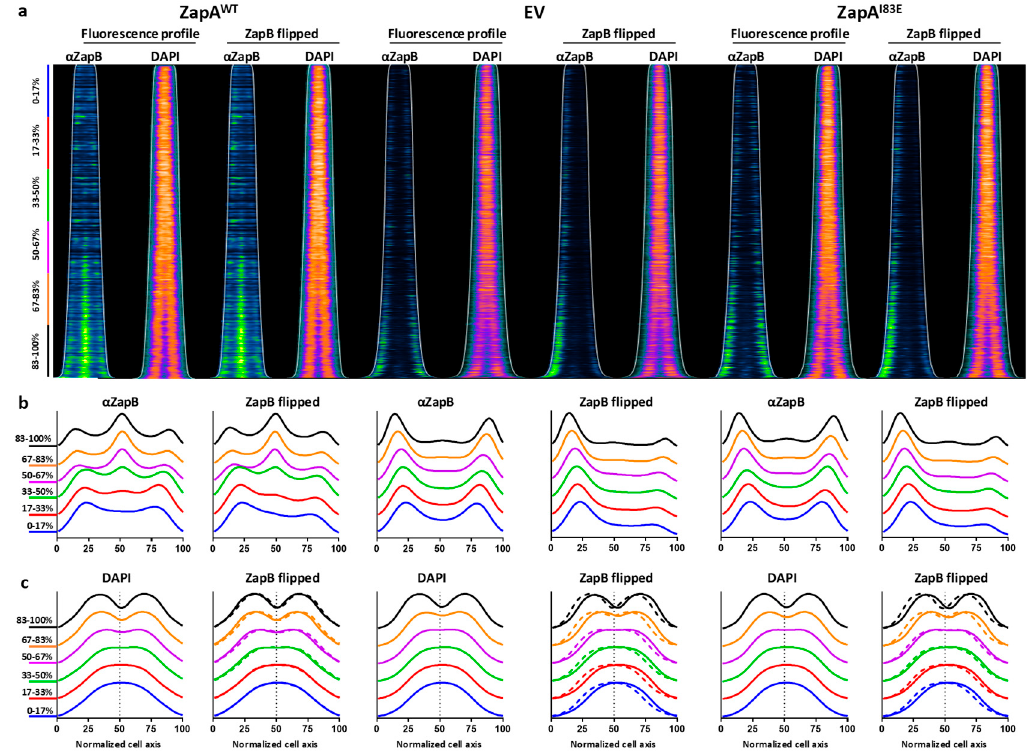
Figure 4. ZapB localized unipolarly in Δ zapA or with ZapA I83E expressed from plasmid and was anti- correlating with the chromosomal position in cells grown to steady state in minimal medium. ( a ) Localization profiles of immunolabeled ZapB and DAPI-stained nucleoids in Δ zapA- expressing ZapA WT , EV, or ZapA I83E . The ZapB profiles showed strong signals at midcell in cells with functional ZapA and polar localization in cells without it or with the mutant ZapA I83E . See Figure 2 for comparison to ZapB localization in cells grown under rich medium conditions. When the cells were sorted according to length and with the strongest polar ZapB signal on the left side of the cell (flipped), predominantly unipolar signals were observed. The DAPI signal in these cells seemed to localize away from ZapB. ( b , c ) The flipped and non-flipped ZapB and DAPI profiles were grouped as 17% age bins and plotted. The DAPI signal in cells without ZapA or with ZapA I83E seemed to have shifted towards the middle of the cells, away from the polar ZapB and showed less invagination (Figure S4). The dashed DAPI profiles represent the mirrored localization and emphasize the changes in chromosome localization patterns. The respective number of analyzed ZapA WT , EV, and ZapA I83E cells were 1089, 3213 and